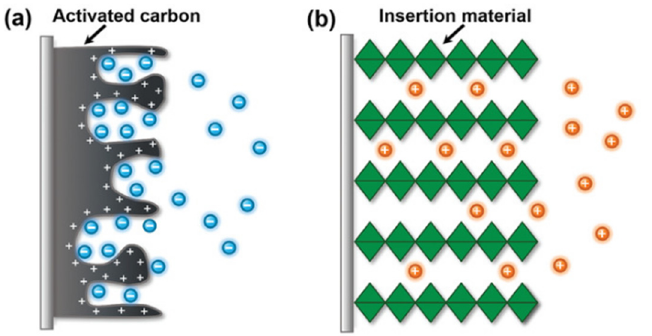
Figure 4. Cell composition of CDI family cells.